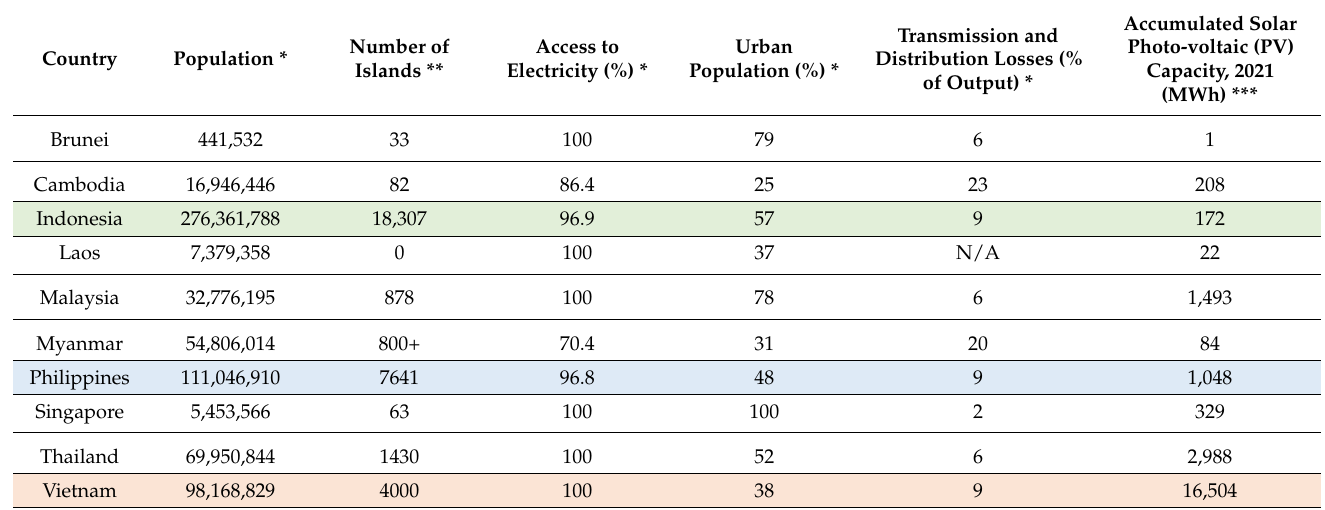
Table 1. Demographics and electricity supply status of ASEAN countries.